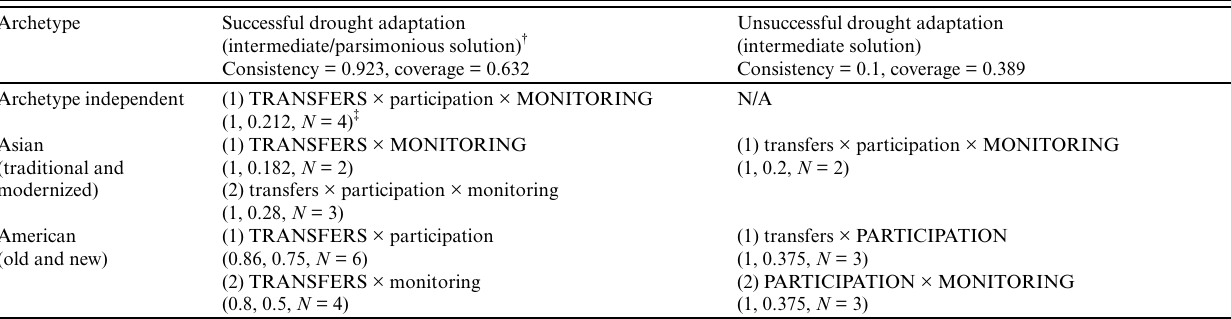
Table 3. Configurations of conditions that are sufficient for successful and unsuccessful drought adaptation. We ran the qualitative comparative analysis including the cluster dummy variable and the three adaptation institutions (transfers, monitoring, and participation). To emphasize the existence of distinct paths depending on the archetype, we display this condition in a separate column. Thus, the first solution of the Asian archetype row was CLUSTER × TRANSFERS × MONITORING, and the first solution of the American model row was cluster × TRANSFERS × participation. Conditions in all-capitals are present in the solution, whereas conditions in lowercase are absent. Conditions that do not appear in the solution are either present or